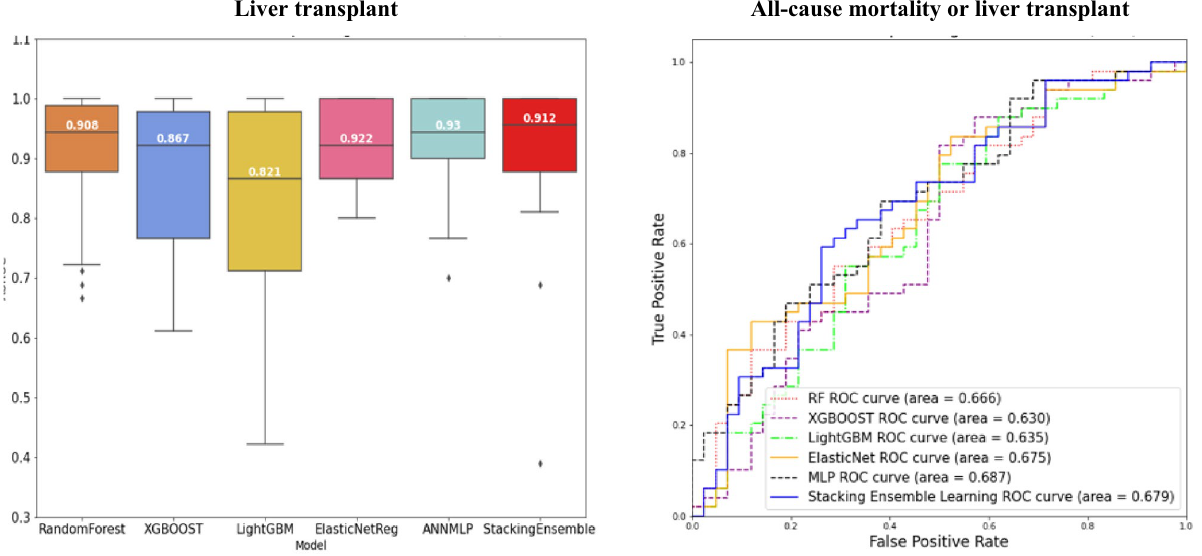
Figure 4. ROC curves for the trained classifiers in the Test Set from one Training-Set split for patients AATD-LD (N = 445). Given the low liver transplant event incidence in AATD-LD patients in the Test Set , there was insufficient data to populate the ROC curve for liver transplant and a box plot was presented